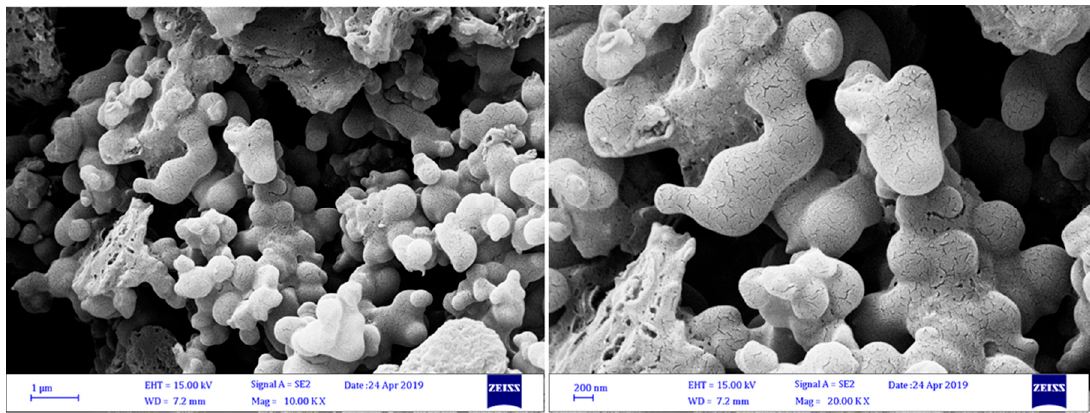
Figure 3. Field emission-scanning electron microscope (FESEM) images of 2 .